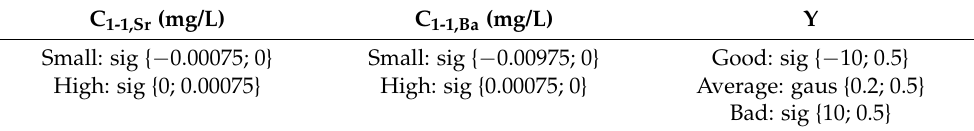
Table 4. Ranges for the variability of input quantities (real and linguistic).